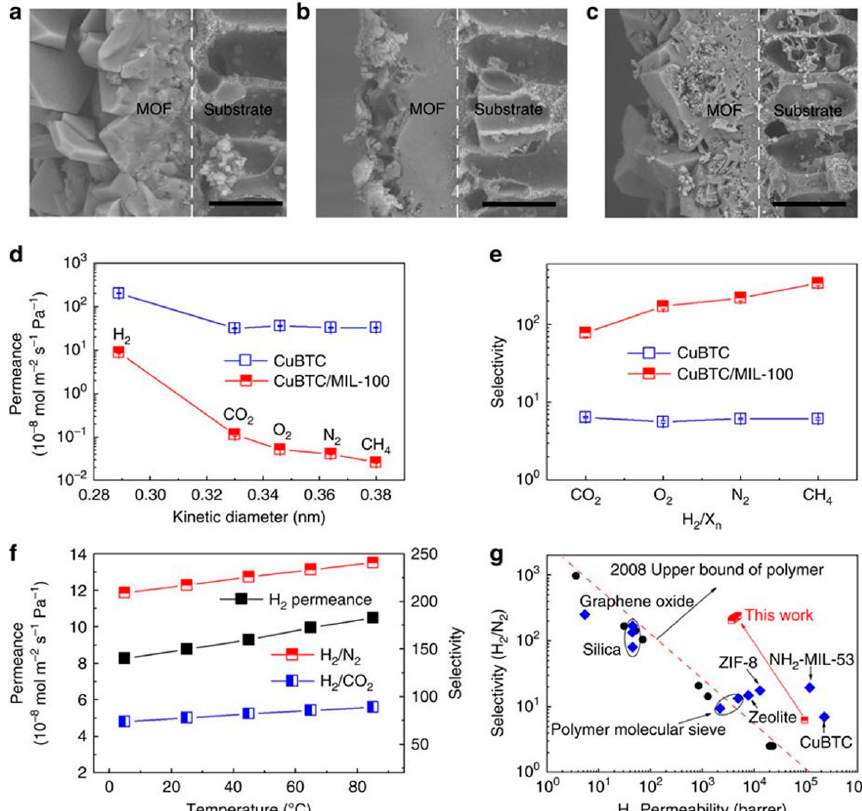
Figure 31. ( a – c ) SEM images of original CuBTC membrane, transformed CuBTC/MIL-100 membrane and transformed CuBTC/MIL-100 membrane after purification, respectively. Scale bar, 20 µ m. ( d , e ) Gas permeance and selectivities of the CuBTC and CuBTC/MIL-100 membranes. All the average permeation results with standard deviation were calculated from three measurement data. ( f ) Effect of temperature on H 2 permeance and H 2 /CO 2 and H 2 /N 2 selectivities for CuBTC/MIL-100 membrane. ( g ) Comparison of CuBTC/MIL-100 membrane with polymeric, silica, zeolite, other MOF, and graphene oxide membranes for H 2 /N 2 system. 1 barrer = 3.348 × 10 − 16 mol m − 2 s − 1 Pa − 1 , the red dotted line is the Robeson’s upper-bound reported in 2008. (adapted with permission from ref. [131].).